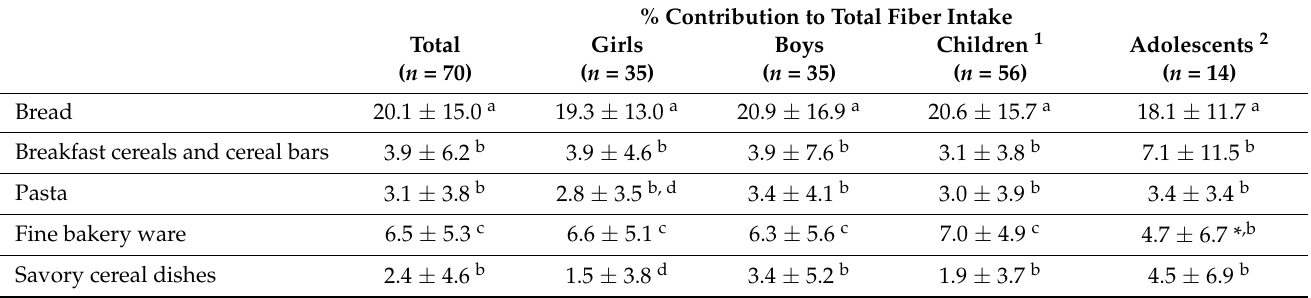
Table 8. Contribution of the different types of gluten-free products of to the daily fiber intake in Spanish children and adolescents, both genders, with celiac disease.